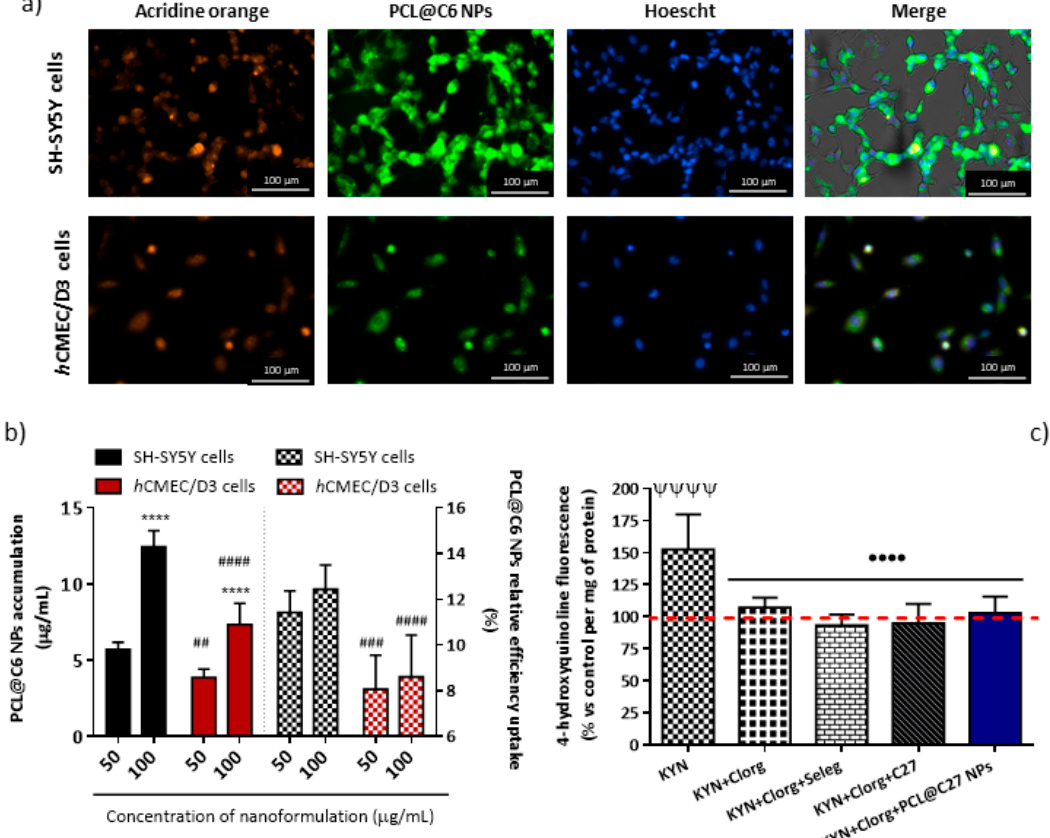
Figure 7. Representative images of acridine-orange and Hoescht stained SH-SY5Y and h CMEC/D3 cells treated with PCL@C6 NPs at 50 µg/mL for 24 and 5 h, respectively ( a ); accumulation (solid bars) and relative efficiency uptake (patterned bars) of PCL@C6 NPs (50 and 100 µg/mL) in SH-SY5Y and h CMEC/D3 cells after 24 and 5 h of exposure, respectively ( b ); evaluation of the MAO-B inhibitory capacity in SH-SY5Y cells after 8 h of exposure, using kynuramine (KYN) as the substrate and clorgyline (Clorg) and selegiline (Seleg) as standard inhibitors of MAO-A and MAO-B, respectively ( c ). The results are expressed as mean ± SD ( n = 3) and statistical comparisons were made using two-way ANOVA and one-way ANOVA, in cases ( b ) and ( c ), respectively. In all cases, p -values lower than 0.05 were considered significant (**** p < 0.0001 by comparison of di ff erent concentrations tested concentration; ## p < 0.01, ### p < 0.001, and #### p < 0.0001 by comparison the results obtained between the two cell lines tested; ΨΨΨΨ p < 0.0001 by comparison with untreated cells; •••• p < 0.0001 by comparison with cells treated only with kynuramine). The dashed red line represents the control